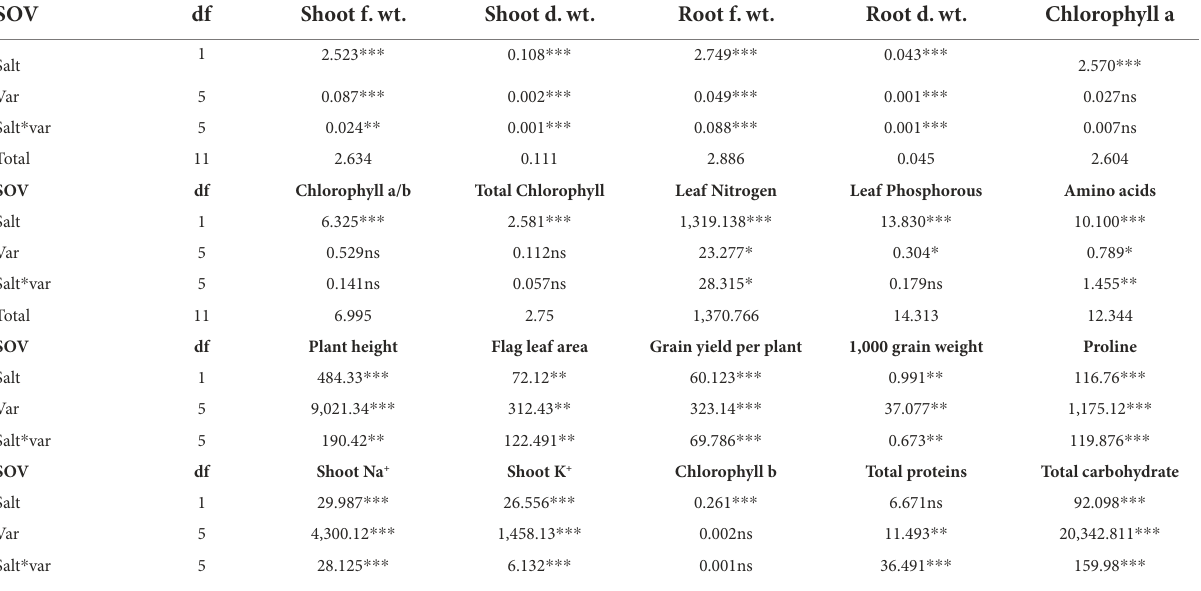
TABLE 1 ANOVA values of the data from growth attributes, yield related attributes, and physiological and biochemical attributes of six varieties when subjected to 150 mM salt stress. SOV df Shoot f.